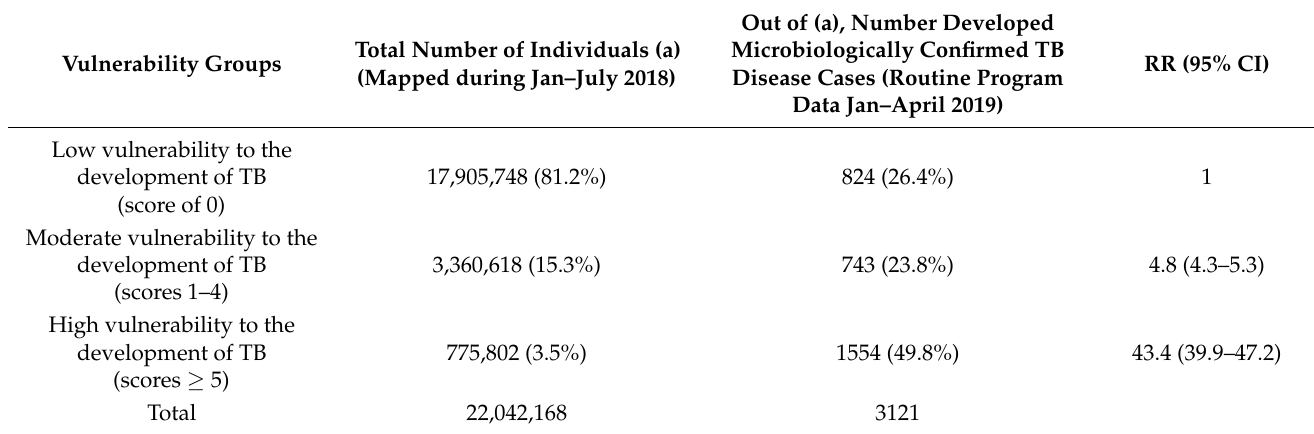
Table 1. Summary of TB cases that emerged from various vulnerability groups based on vulnerability